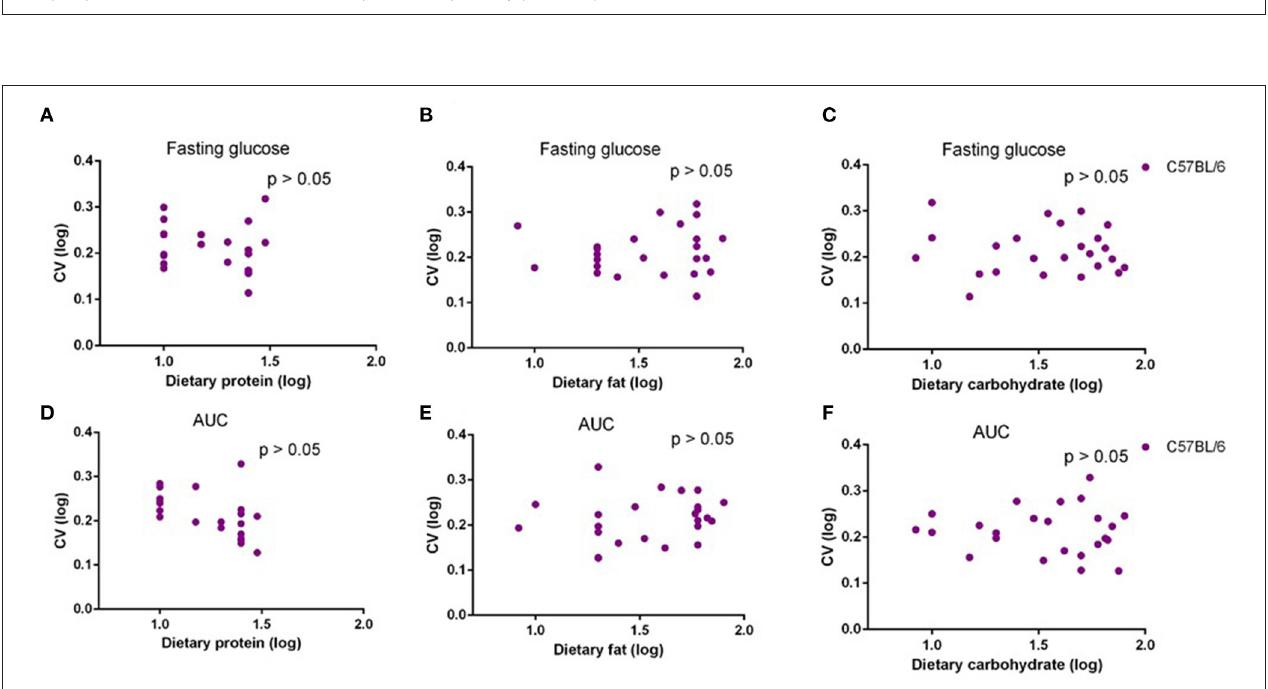
FIGURE 6 | The diagram showing the relationship between dietary macronutrient content and coefficient of variation (CV) of fasting glucose and area under the curve (AUC) of C57BL/6 mice after exposure to different diets. The correlations between logged dietary fat, protein, and carbohydrate contents and (A–C) logged CV of fasting glucose and (D–F) AUC of last week at different diet treatment periods, respectively ( n = 10–11).